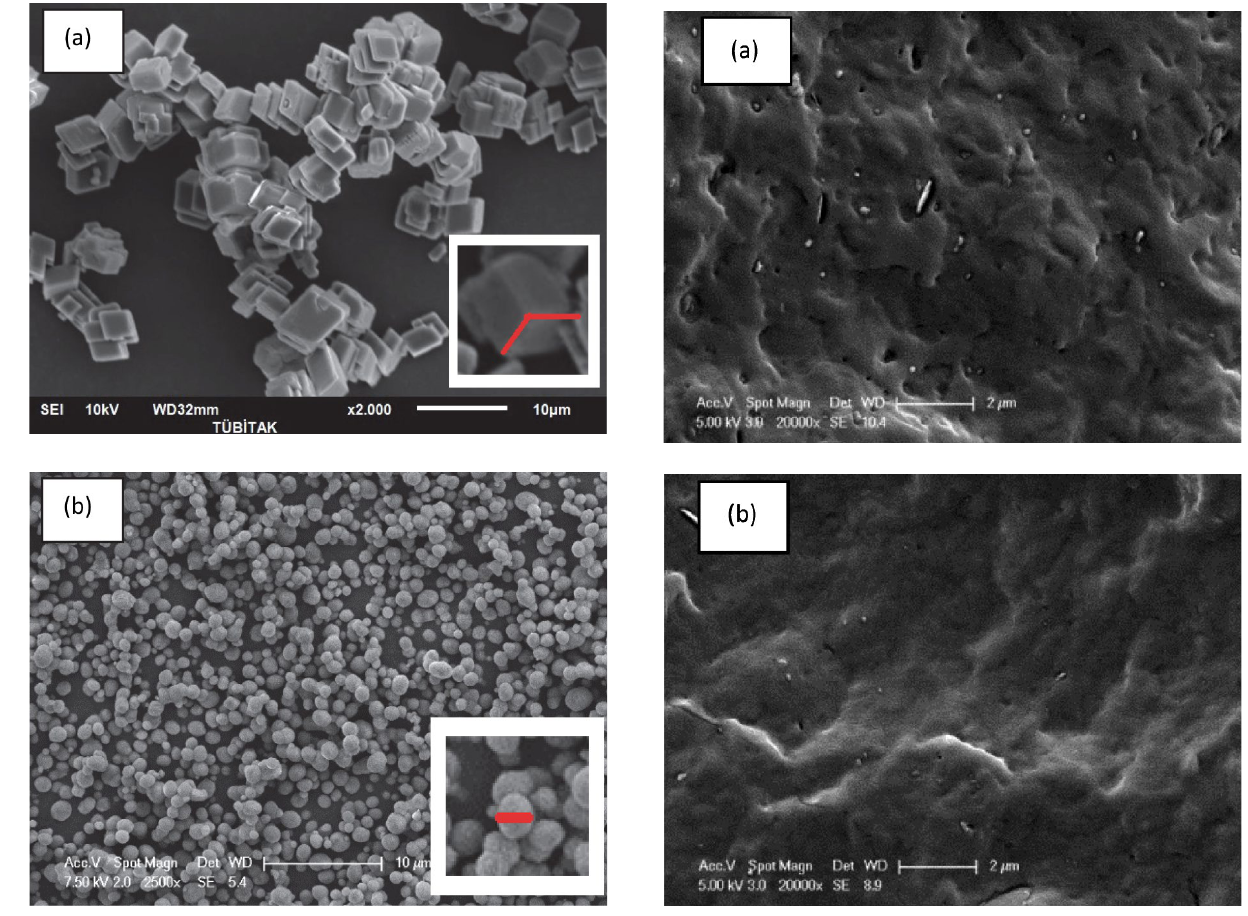
Figure 4. SEM photographs of composites obtained in the presence of (a) 1.0% of calcite and (b) 1.0% of